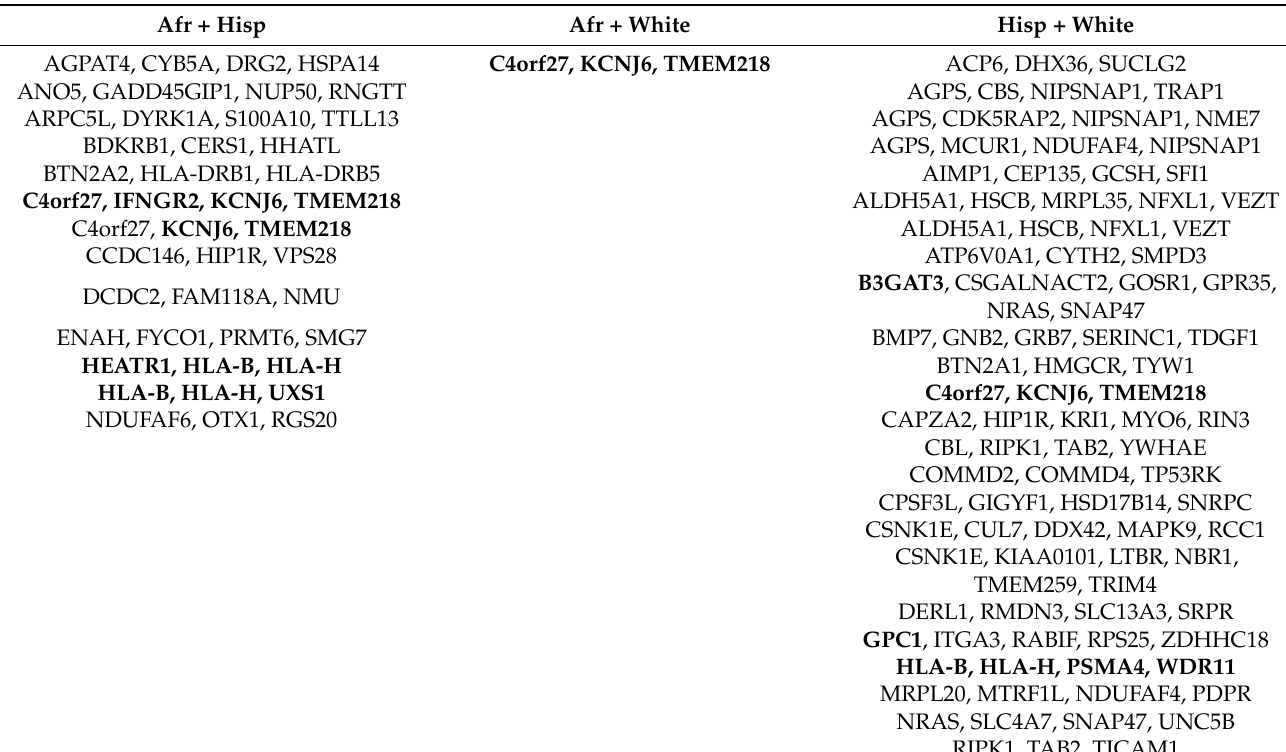
Table 2. Shared modules between populations. Highlighted genes in bold are further discussed in the